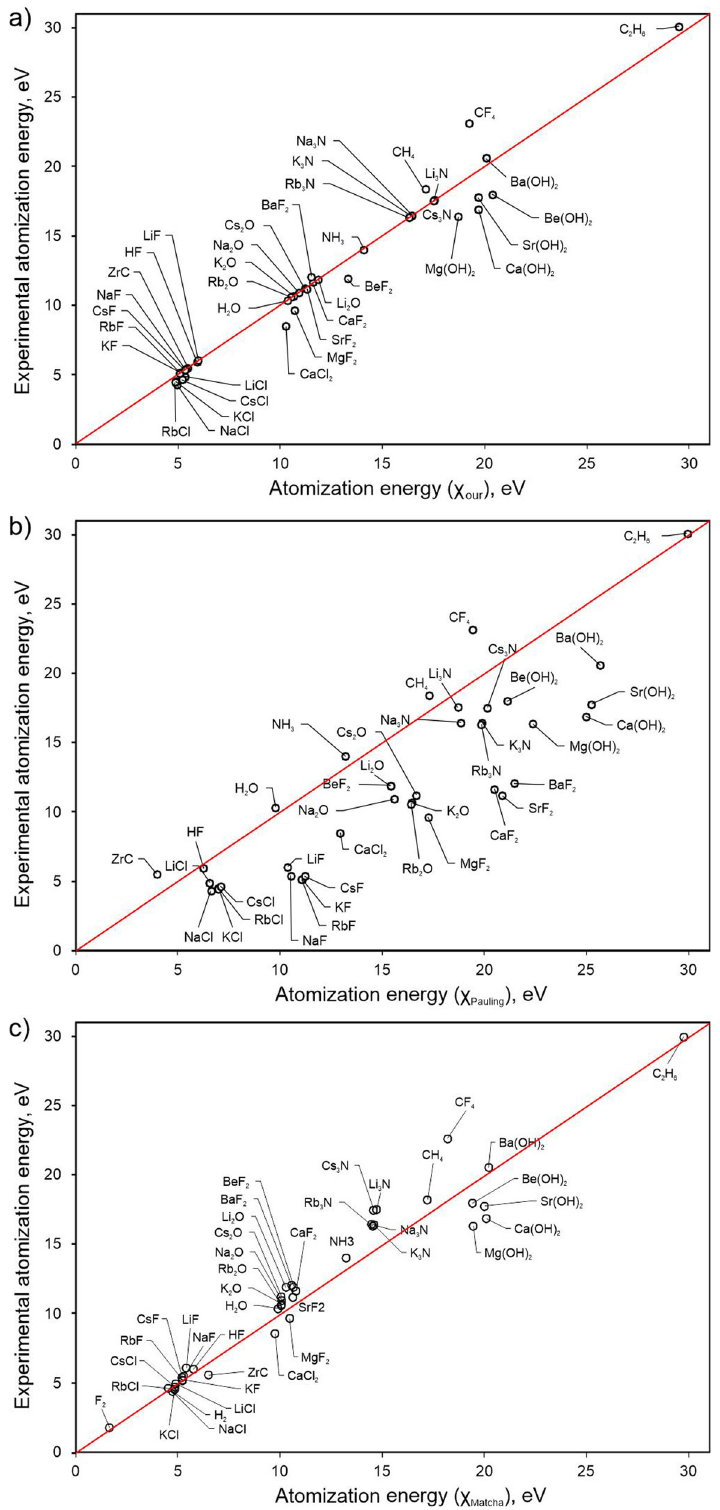
Fig. 4 Atomization energies predicted from thermochemical electronegativities ( x -axis) for a number of simple molecules in comparison with experimental atomization energies on y -axis. ( a ) Experimental vs our, ( b ) experimental vs Pauling ’ s ( c ) and experimental vs Pauling ’ s corrected by Matcha 8 . Lines indicate the ideal results, the root-mean-square deviations from which are 0.17 eV/atom for our approach, 1.21 eV/atom for Pauling ’ s, and 0.25 eV/atom for Matcha ’ s (the relative errors on atomization energies are 5%, 40, and 7%,